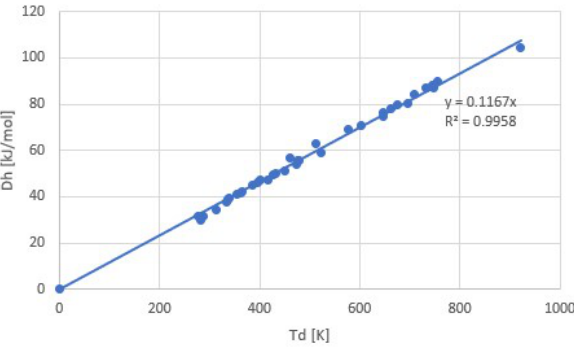
Figure 8. Trouton’s rule for ammoniates of chloride salts. This plot was constructed from the pT-lines of chloride ammoniates transitions of Figure 7. The regression coefficient r 2 = 0.9958 is even better than for the vapor-liquid transitions of common liquids of Figure 6.